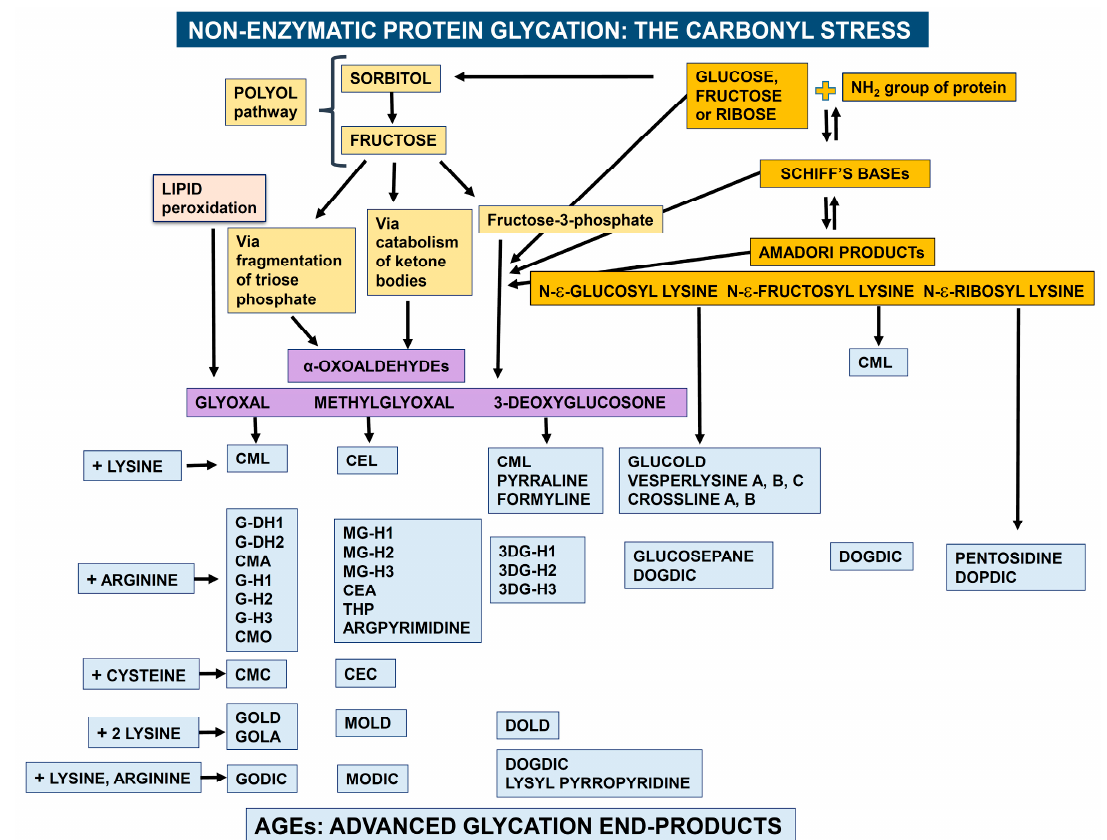
Figure 1. Schematic representation of non-enzymatic protein glycation. Details of these degradation patterns have been reported elsewhere [7,8]. Legend for AGE abbreviations is reported in Box 1. Box 1. Nomenclature for the most common AGEs.